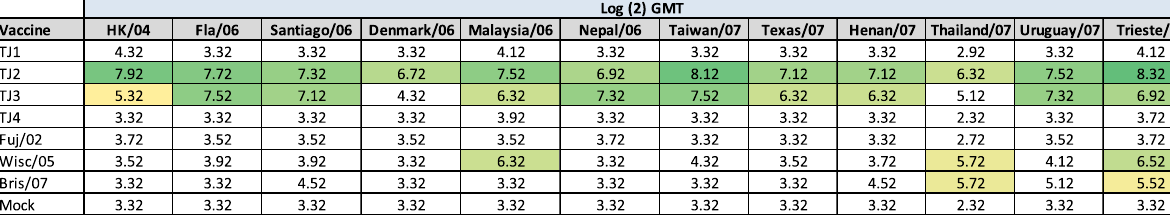
Table 2. 2004–2007 H3N2 Co-circulating influenza virus HAI panel. HAI assays were performed against a panel of co-circulating influenza strains isolated from 2004–2007 with day 70 serum from vaccinated mice. The average log 2 geometric mean HAI serum antibody titers (GMTs) were determined for each group of mice (n = 5) and are presented in a heat map form. Colored cells represent groups that achieved a GMT ≥ 5.32, which